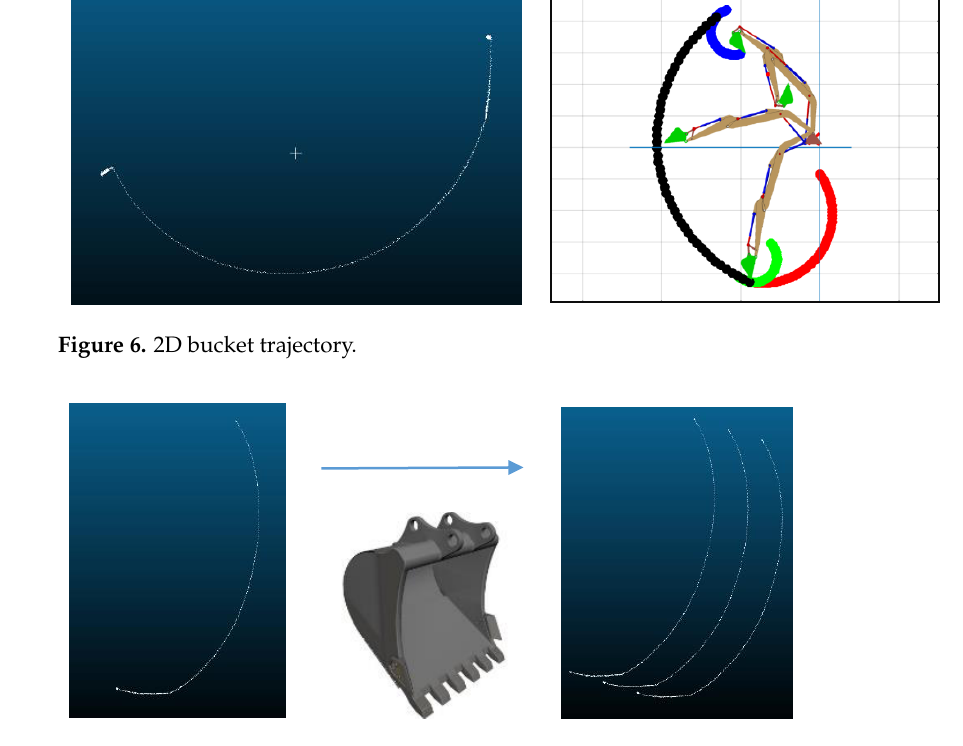
Figure 8. Application of the meshing technique to 2D bucket trajectory. 4.3. Map Reconstruction for Occlusion Areas The reconstruction of a map for occlusion areas requires a fusion of proprioceptive and exteroceptive maps. For this process, a global coordinate system was defined first with its origin that was set to be the boom base of the excavator. Then, the sensor (local) coordinates were transformed into the global coordinate using the point cloud transfor- mation matrices. After achieving a unified global coordinate system, the initial ground map built based on the vision sensor data was merged with a 3D mesh of the bucket tra- jectory. The final reconstructed map can be seen in Figure 9 where the occluded area in the initial map is filled with the proprioceptive map. Figure 9. The final reconstruction map for occluded areas using proprioceptive and exteroceptive sensing data.